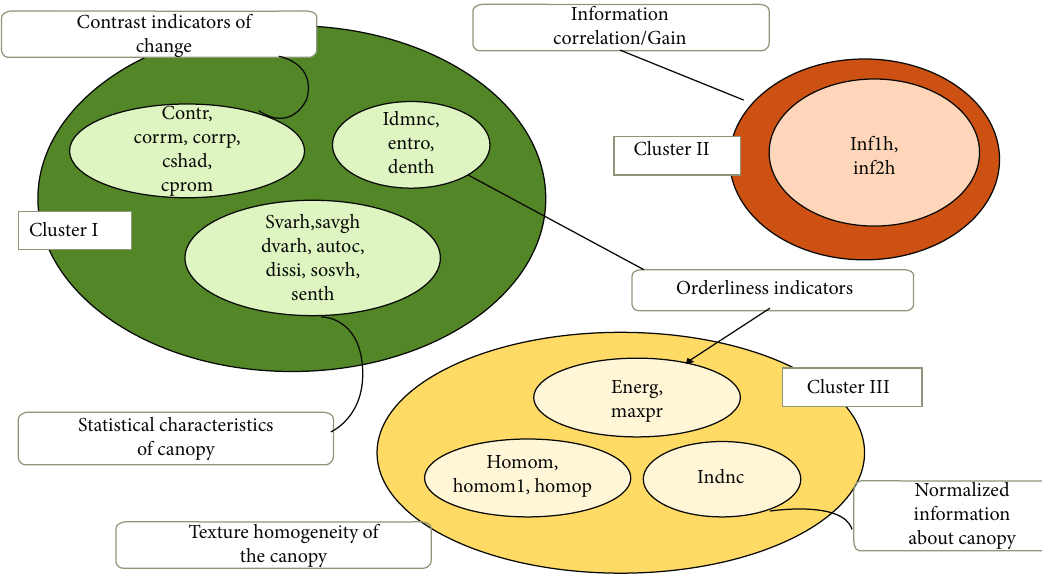
Figure 11: Visualization of clusters